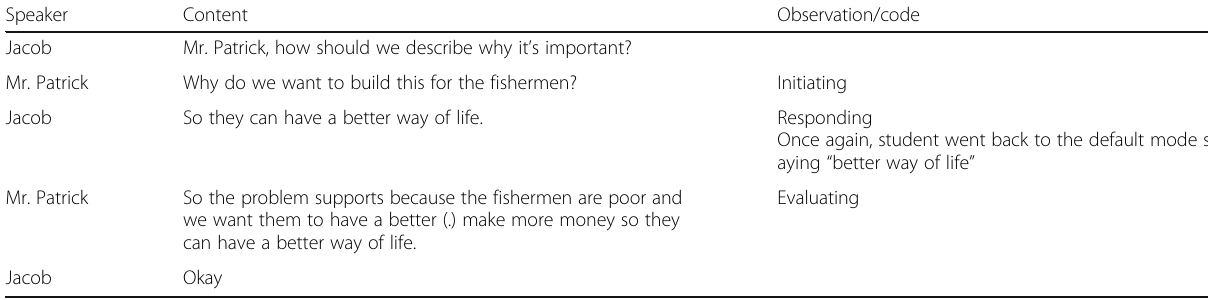
Table 3 Conversation between Mr. Patrick and Jacob during the last day of the unit in lesson 12 Speaker